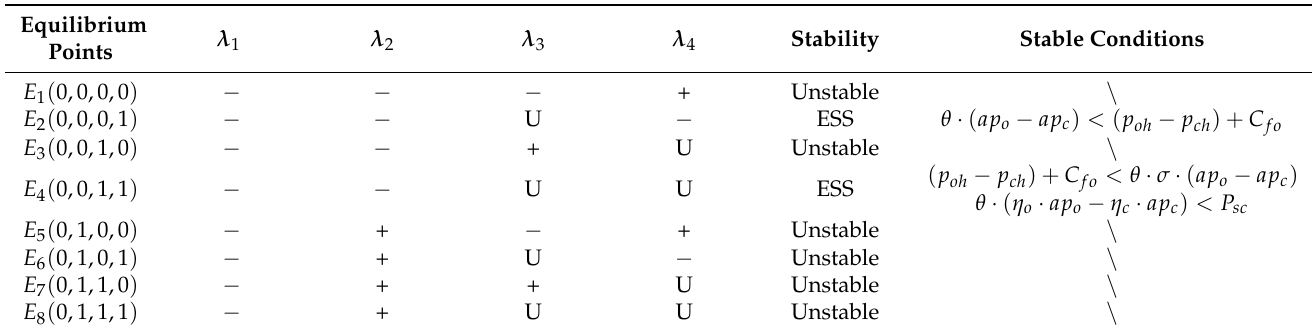
Table 4. Stability analysis of equilibrium points when local governments choose loose regulation (1 − g